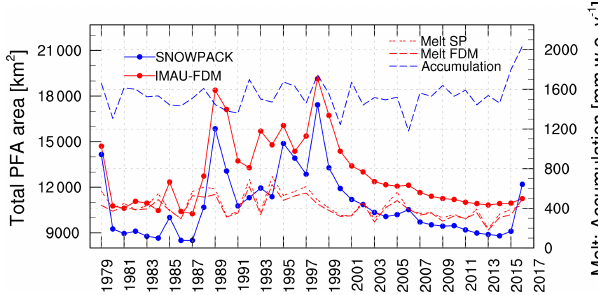
Figure 7. Yearly area (number of grid points multiplied by the grid box area) of PFAs for SNOWPACK (solid blue line) and IMAU- FDM (solid red line) on the left axis and yearly accumulation (dashed blue line) and melt (dashed red lines) averaged over all 941 PFA